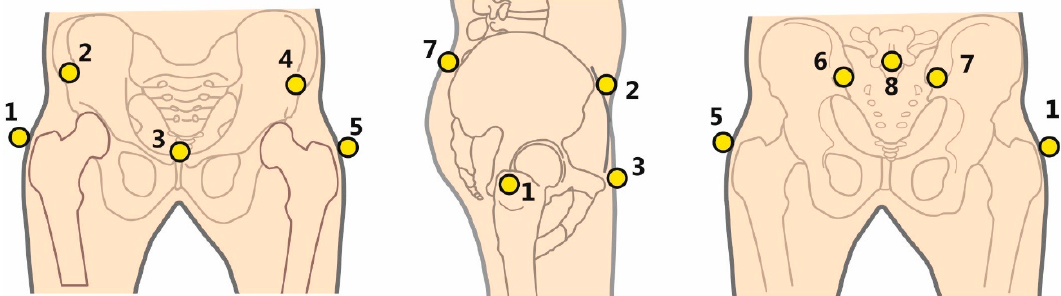
Figure 1. Position of the marker spheres. 1: Trochanter major right, 2: spina iliaca anterior superior (ASIS) right, 3: symphysis, 4: ASIS left, 5: trochanter major left, 6: spina iliaca posterior superior (PSIS) left, 7: PSIS right, 8: S1.